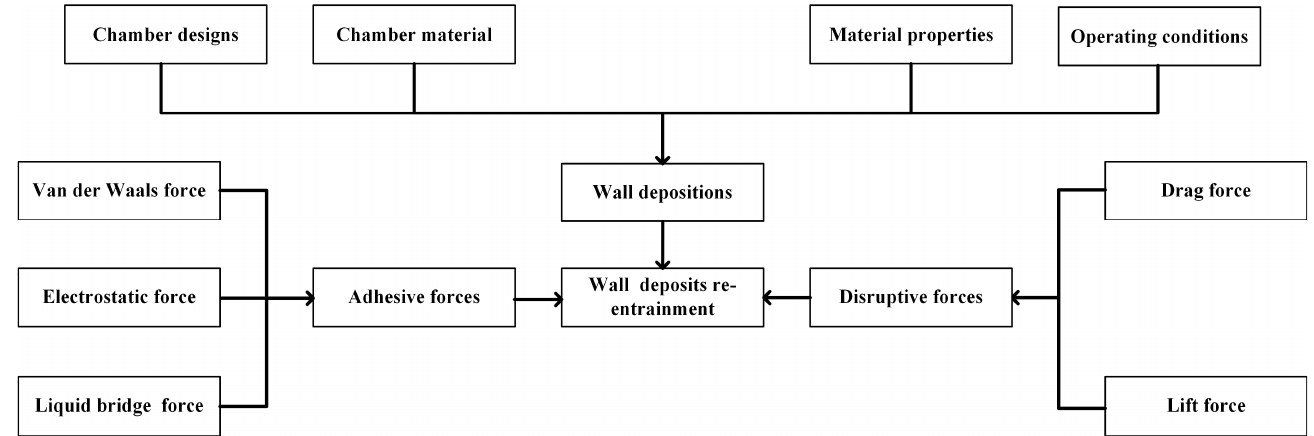
Figure 10. Factors affecting the wall deposition and wall deposit re-entrainment.